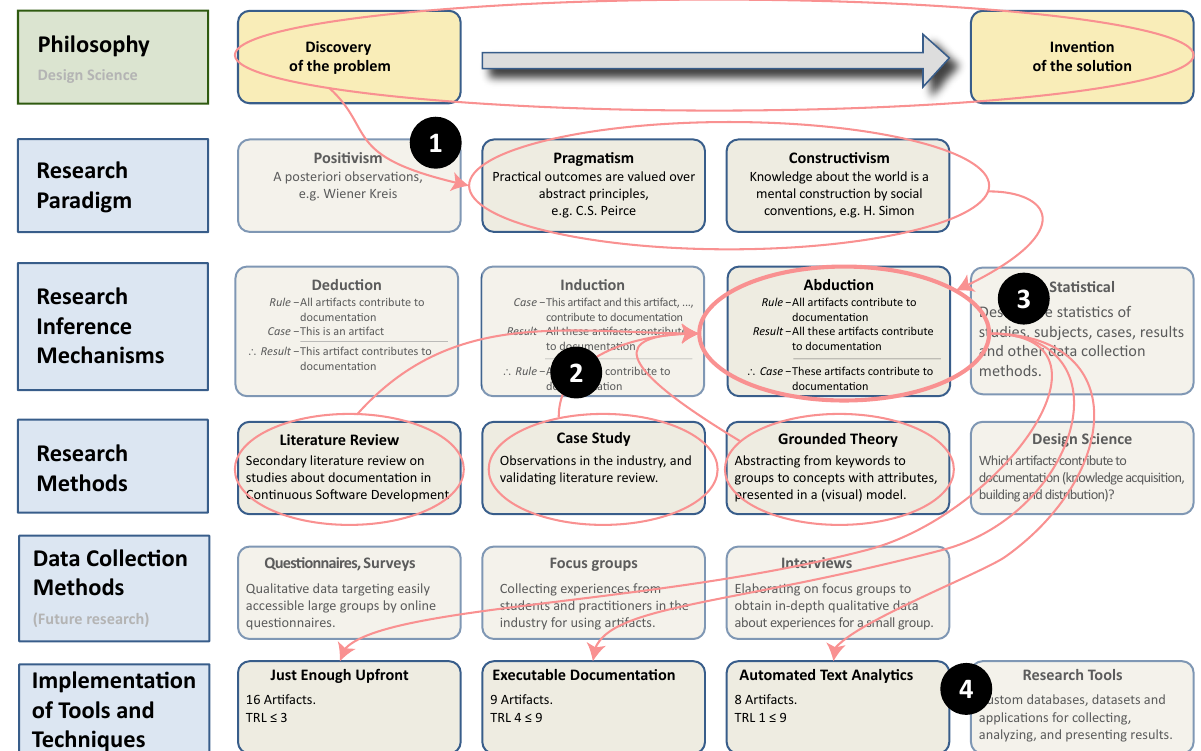
Figure 4. The Conceptual Research